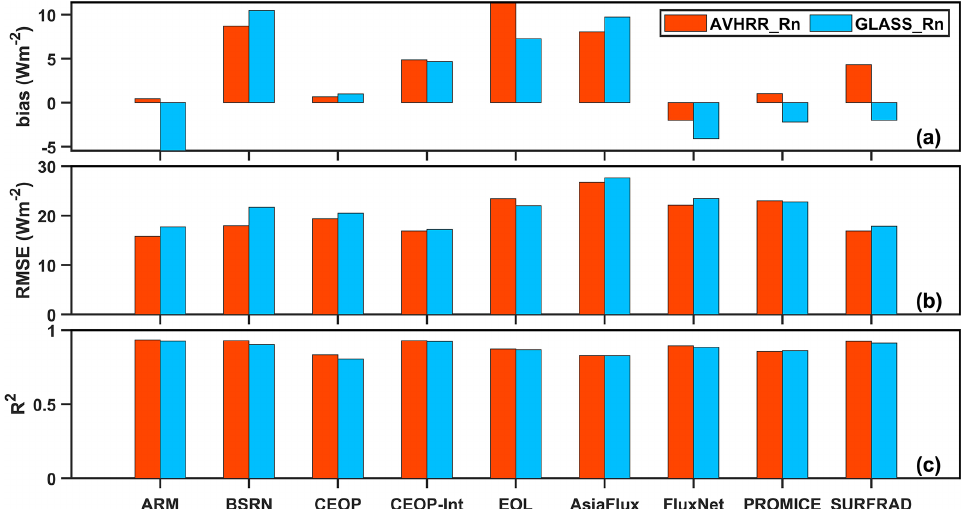
Figure 7. The average performance of the AVHRR and GLASS R n retrievals against ground-based measurements at the reliable sites over each